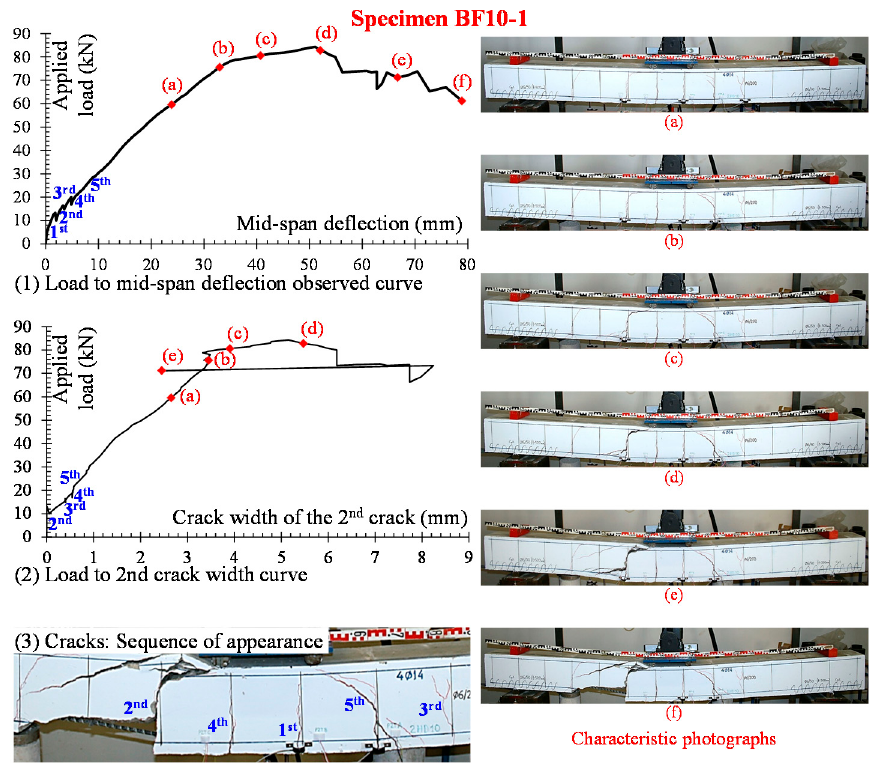
Figure 8. Beam BF10-1. Load to midspan deflection (1) and load to crack width (2) observed curves. Photographs at characteristic points ( a ) to ( f ). Sequence of appearance of the observed cracks (3).